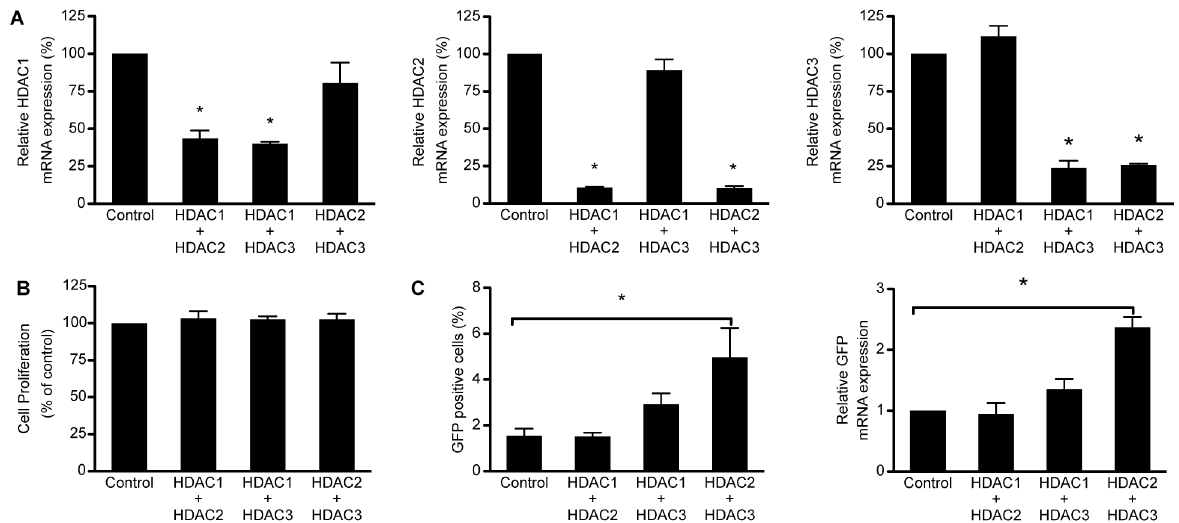
Figure 2. Co-depletion of HDAC2 and HDAC3 significantly increases expression from the HIV-1 promoter. A. Expression of the indicated HDAC mRNAs following shRNA mediated depletion of HDAC1 and 2 2, HDAC1 and 2 3, or HDAC2 and 2 3. The depletion was significant and specific for the targeted HDACs. B. Cell proliferation and viability of 2D10 cells that were transduced with shRNAs targeting HDAC1 and 2 2, HDAC1 and 2 3, or HDAC2 and 2 3. No significant changes in cell proliferation and viability were observed following co- depletion of these HDACs as compared to cells that were transduced with the scrambled shRNA control. C. Expression of GFP from the HIV-1 promoter following depletion of HDAC2 and 2 3 increased compared to the control cells transduced with a scrambled shRNA. However, depletion of HDAC1 and 2 2 or HDAC1 and 2 3 did not have a significant effect on GFP expression. This same result was seen when GFP mRNA expression was directly measured. Expression was not significantly altered from baseline following transduction with non-specific shRNA. (*p , 0.05). doi:10.1371/journal.pone.0102684.g002 mediated depletion. HIV-1 LTR expression in the presence of the selective inhibition of HDAC1 and 2 2 with 20 m M of the drug vehicle (DMSO) used for these inhibitors is low, and the effect of Mrk12 [21], depletion of HDAC1 did not significantly affect the HDAC3 depletion was significant (Fig. 4A). In the presence of